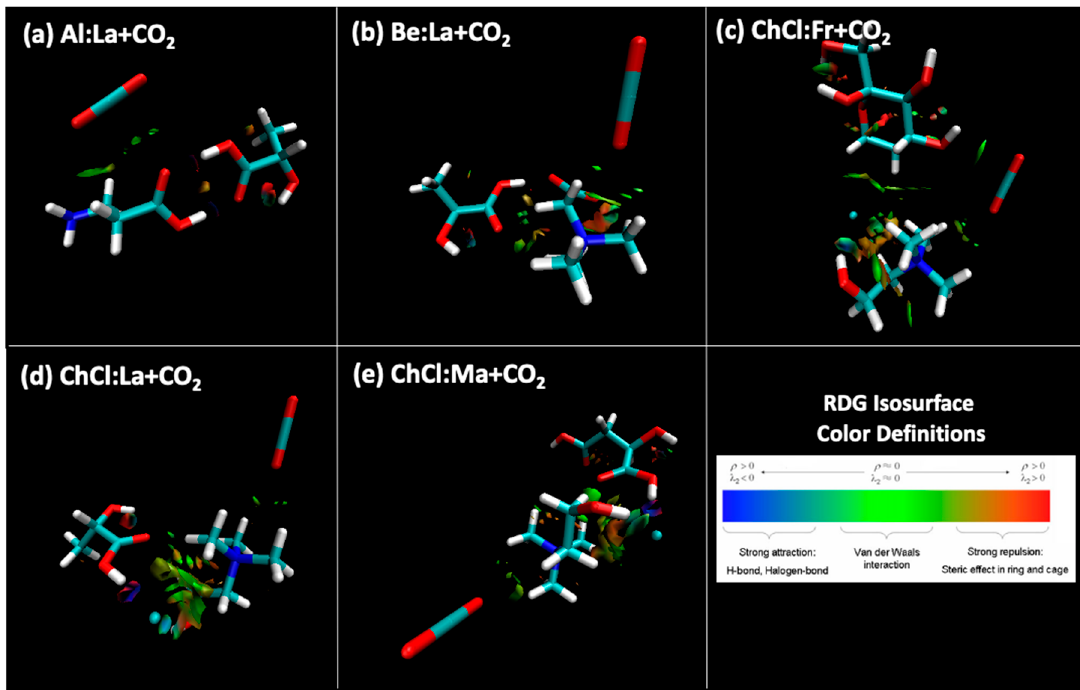
Figure 5. Reduced density gradient (RDG) isosurfaces for HBA + CO 2 and HBD + CO 2